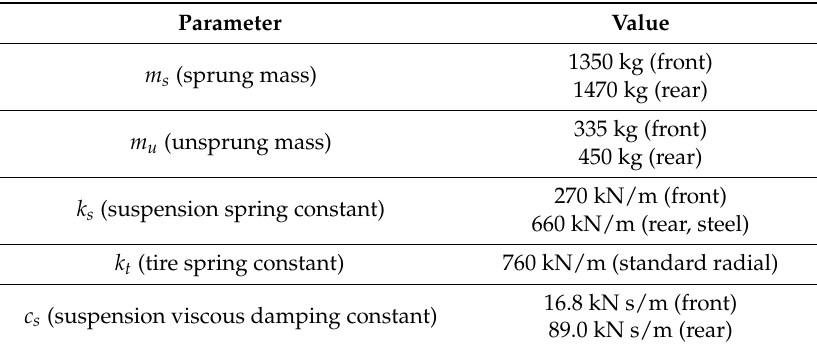
Table 3. Mechanical parameters of the quarter-truck model [32].